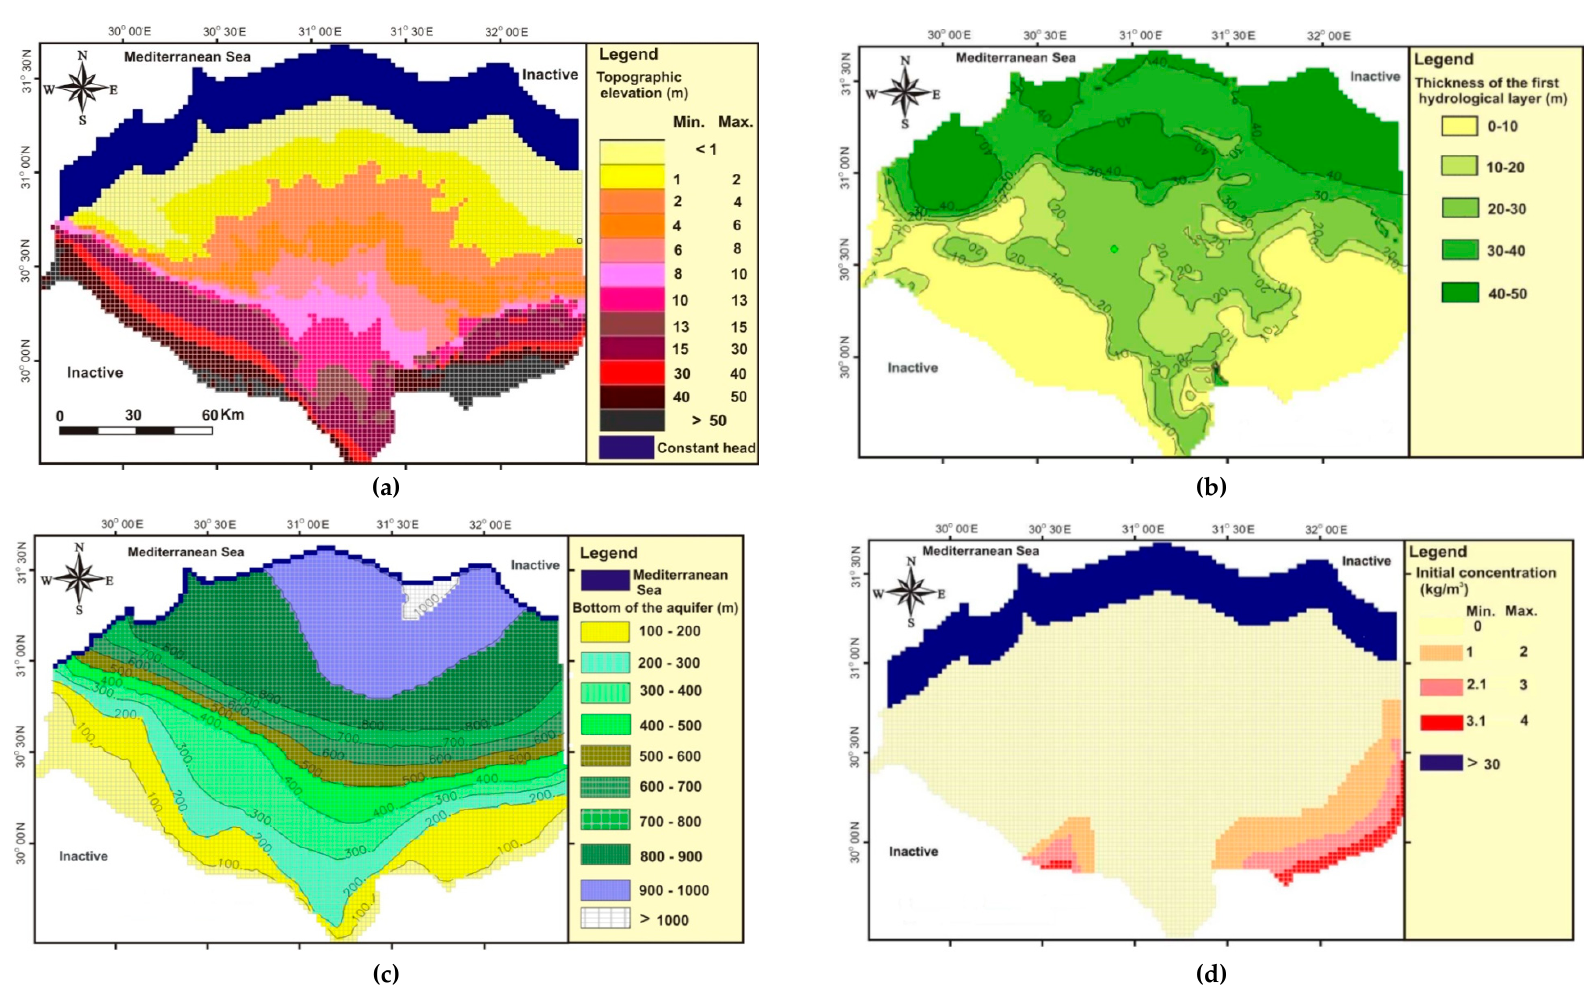
Figure 2. ( a ) Elevations of the study area specified in the first modeling layer. ( b ) Thickness of the first hydrological layer (Holocene). ( c ) The bottom of the second hydrological layer (Pleistocene). ( d ) Salinity concentration in kg/m 3 of the boundary condition in the deepest modeling layer, modified from data used in [5].